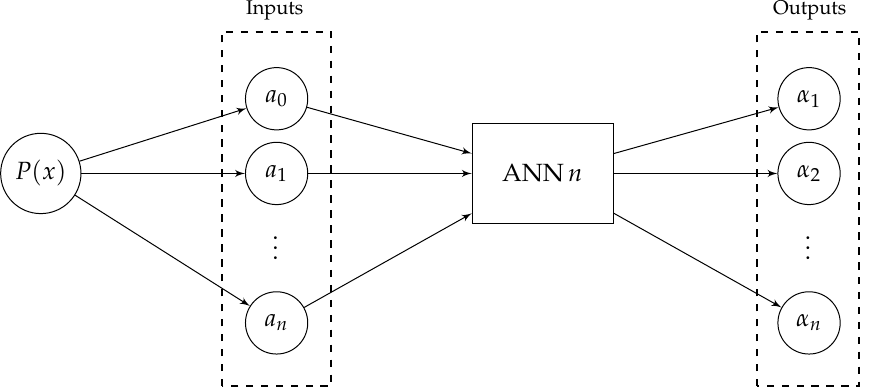
Figure 1. Block diagram showing the coefficients of a polynomial being feed as inputs to the ANN, which in turn outputs an approximation for each